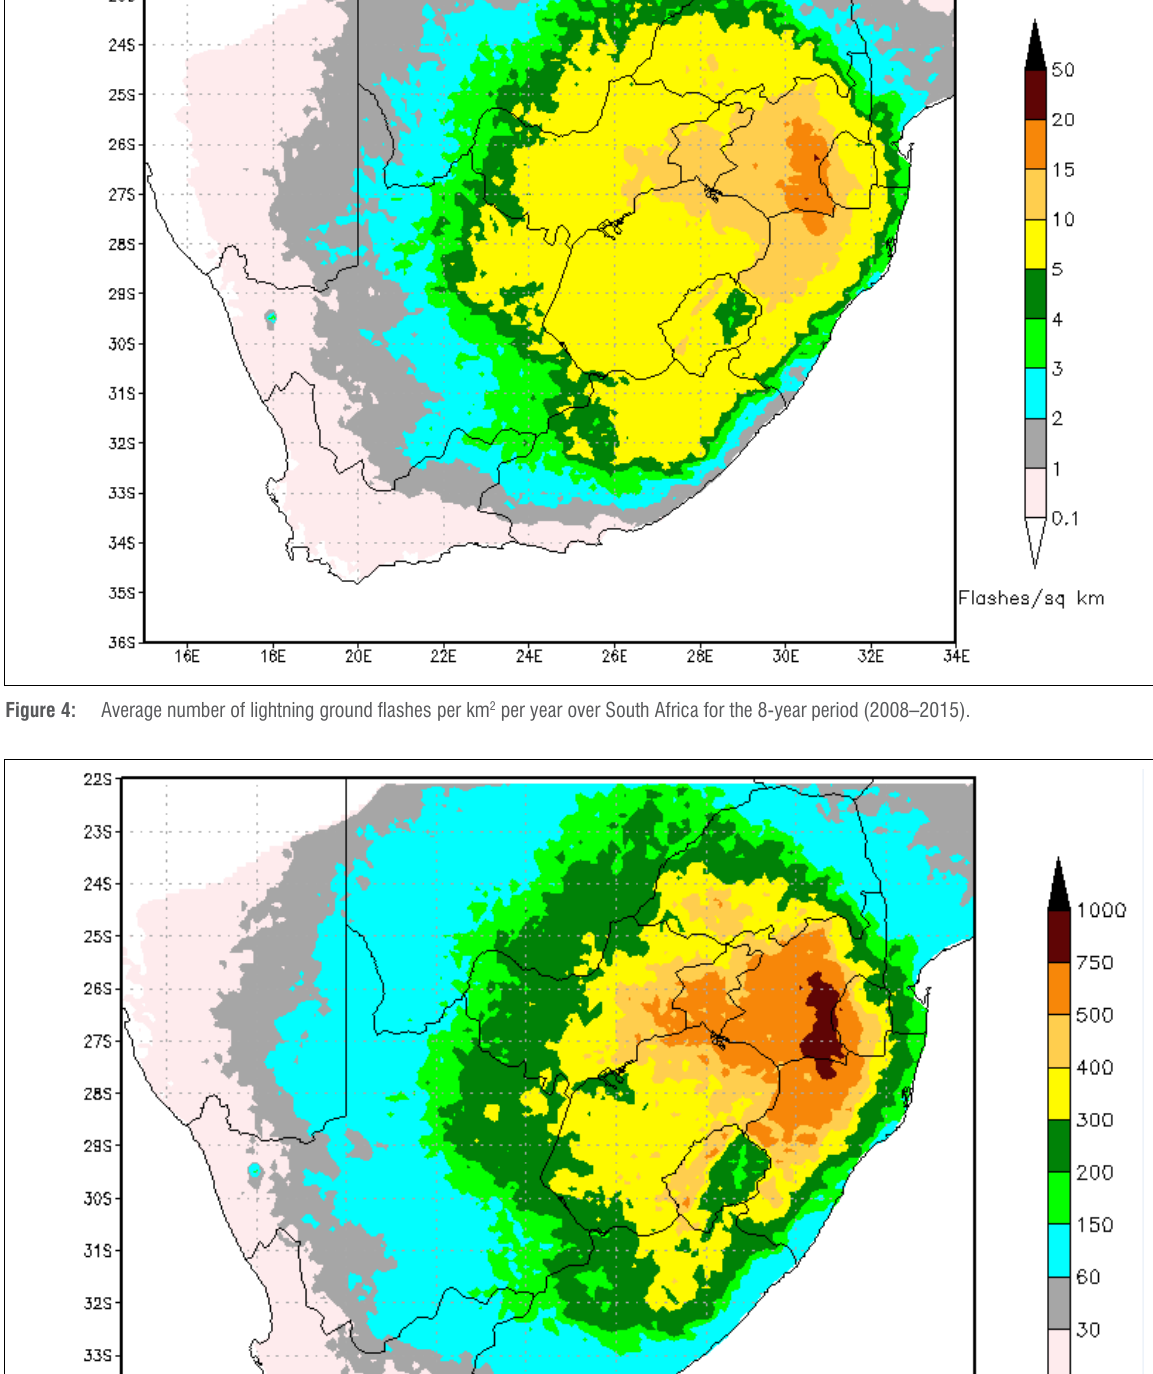
in (kg NO /km²/year), using the emission factor of Schumann and Huntrieser 40 x 2